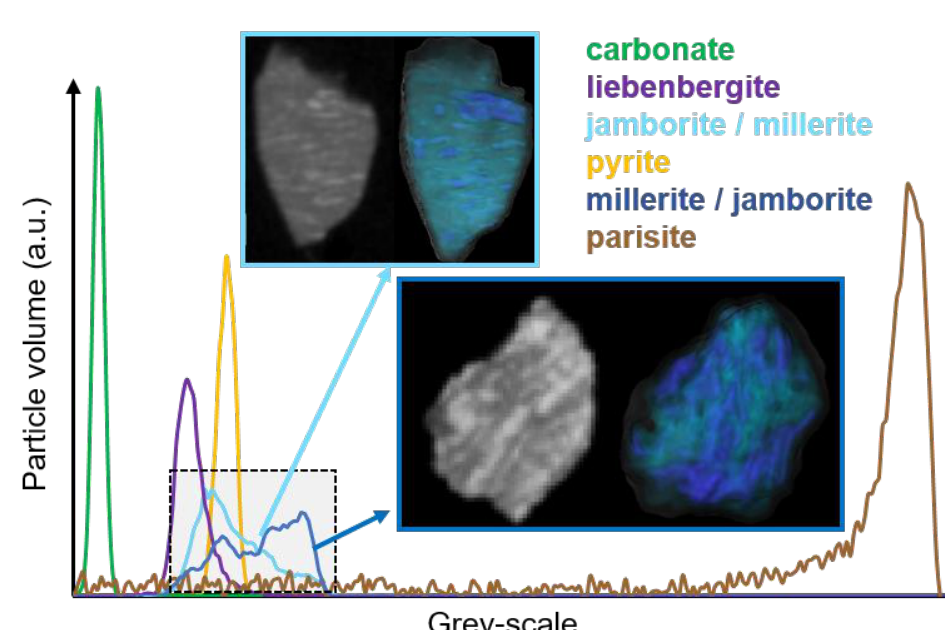
Figure 5. Histogram of individual particles that represent the mineral phases or mineral groups identified by the MLA analysis. The two histograms in blue correspond to the two particles represented in 2D (grey) and in 3D (color) that have an intergrown microstructure of millerite and jamborite, whereby the particle with predominant light blue has a higher fraction of jamborite and the particle with predominant dark blue has a higher fraction of millerite.